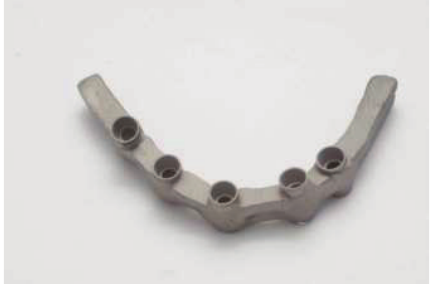
Figure 7: Prosthesis immediately after installation.